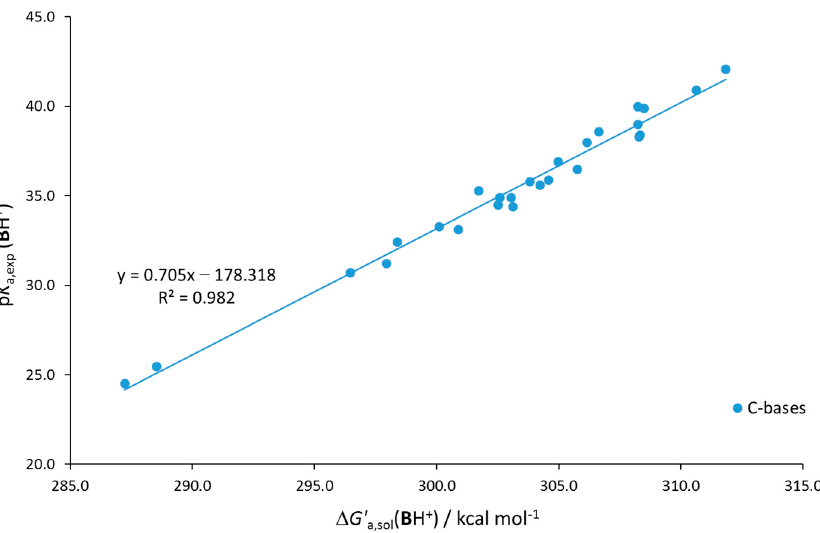
Figure 3. Correlation of experimental p K a against the reduced Gibbs energy of dissociation ( ∆ G’ a.sol ( B H + )) obtained using the IPCM//M6 computational approach with off-liners excluded. MUE = 0.5, RMS = 0.6. Adding outliers to the correlation dropped R 2 to 0.825, with MUE = 1.0 and RMS =